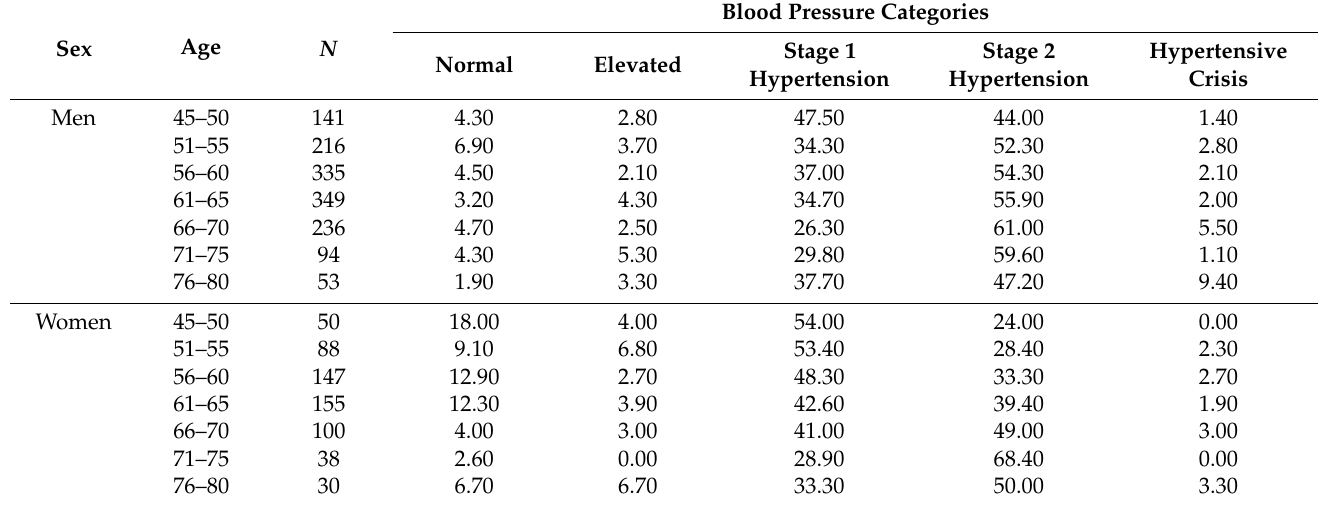
Table 3. The prevalence (%) of ‘normal’, ‘elevated’, ‘stage 1 hypertension’, ‘stage 2 hypertension’ and ‘stage 3 hypertension’ blood pressures in the study participants ( N =